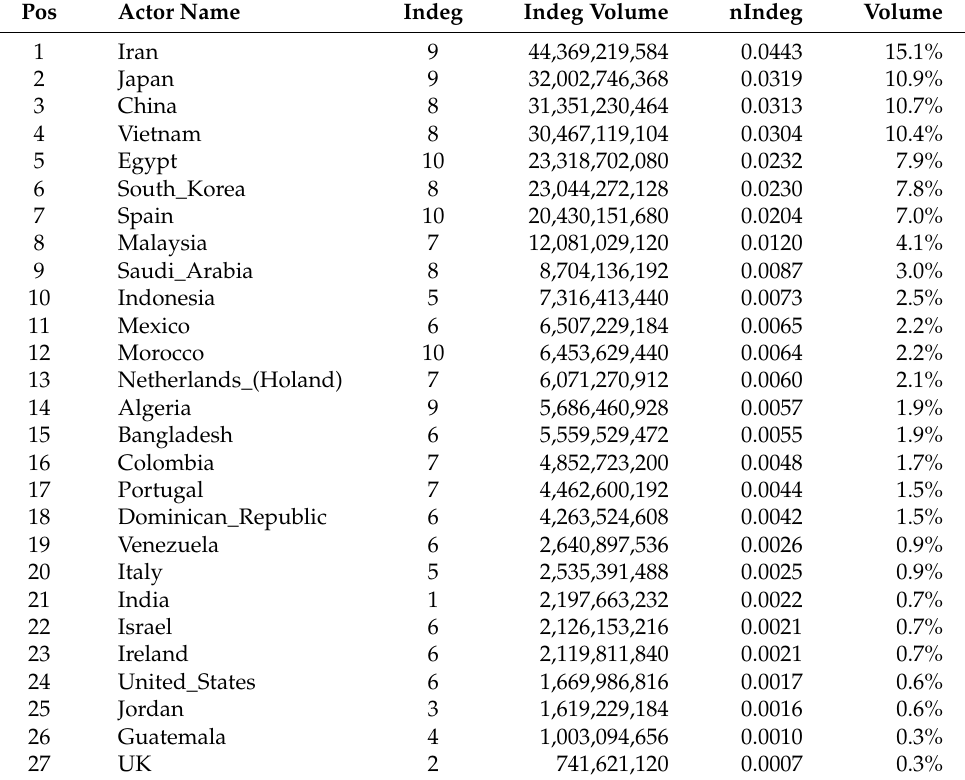
Table 3. Importer countries